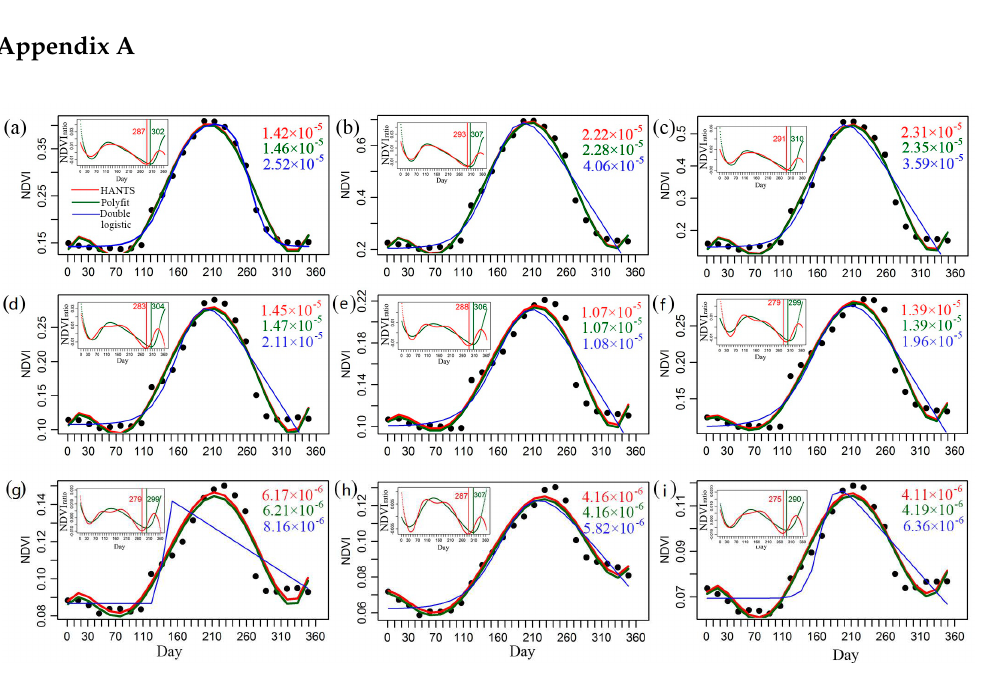
Figure A2. Relative proportions of the three climate variables that contributed to the EOS in each subregion. The legend coloring is same as in Figure 5. The white portions indicate that the proportion is not significant ( p > 0.05).